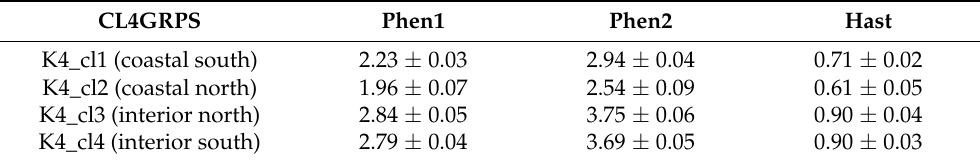
Table 6. Predicted value for Phen1 (phenological score of bud burst on 17 May 2021), Phen2 (pheno- logical score of bud burst on 24 May 2021) and Hast (difference between the two phenological scores as an indicator of bud burst speed).